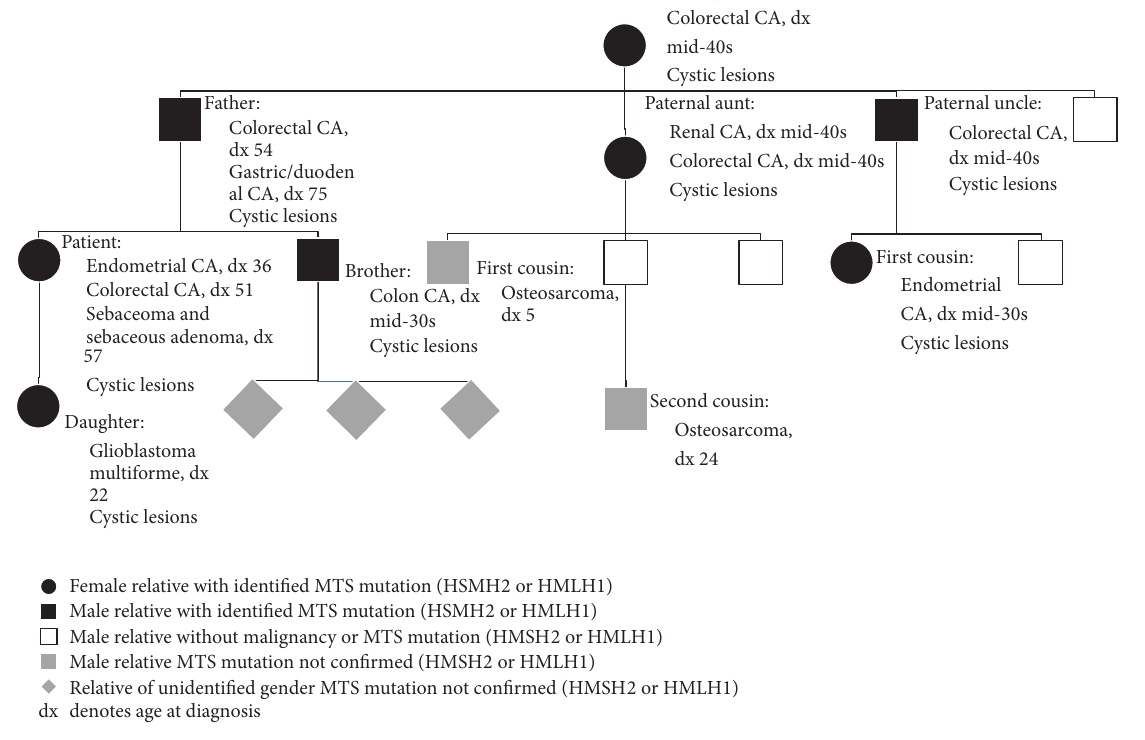
Figure 2: The patient’s family history, including visceral malignancies and MMR mutation